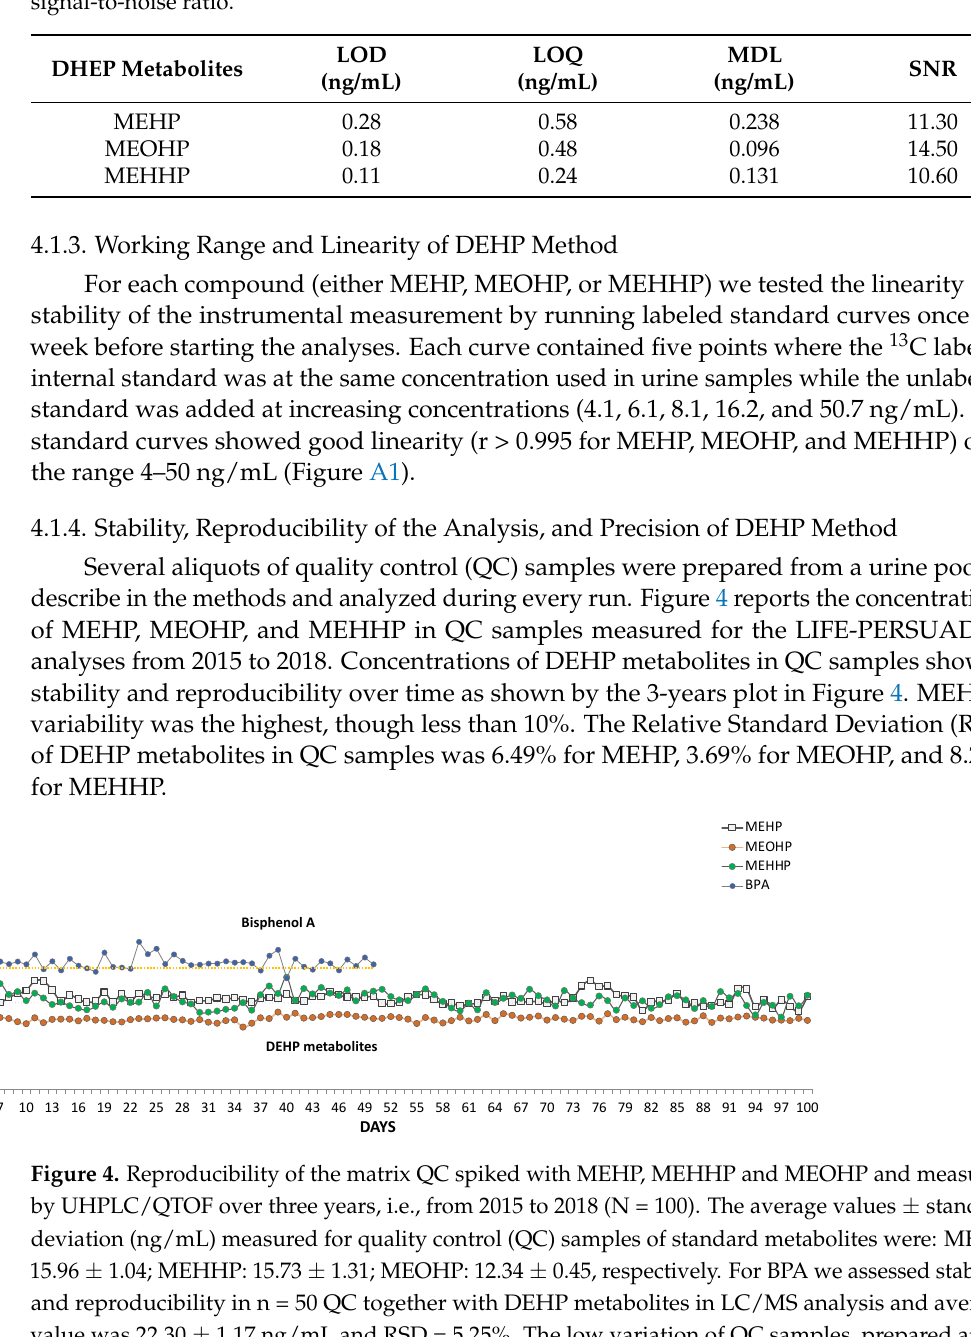
Table 4. Limit of Detection (LOD), Quantification (LOQ), and Method Detection Limit (MDL); SNR: signal-to-noise ratio.